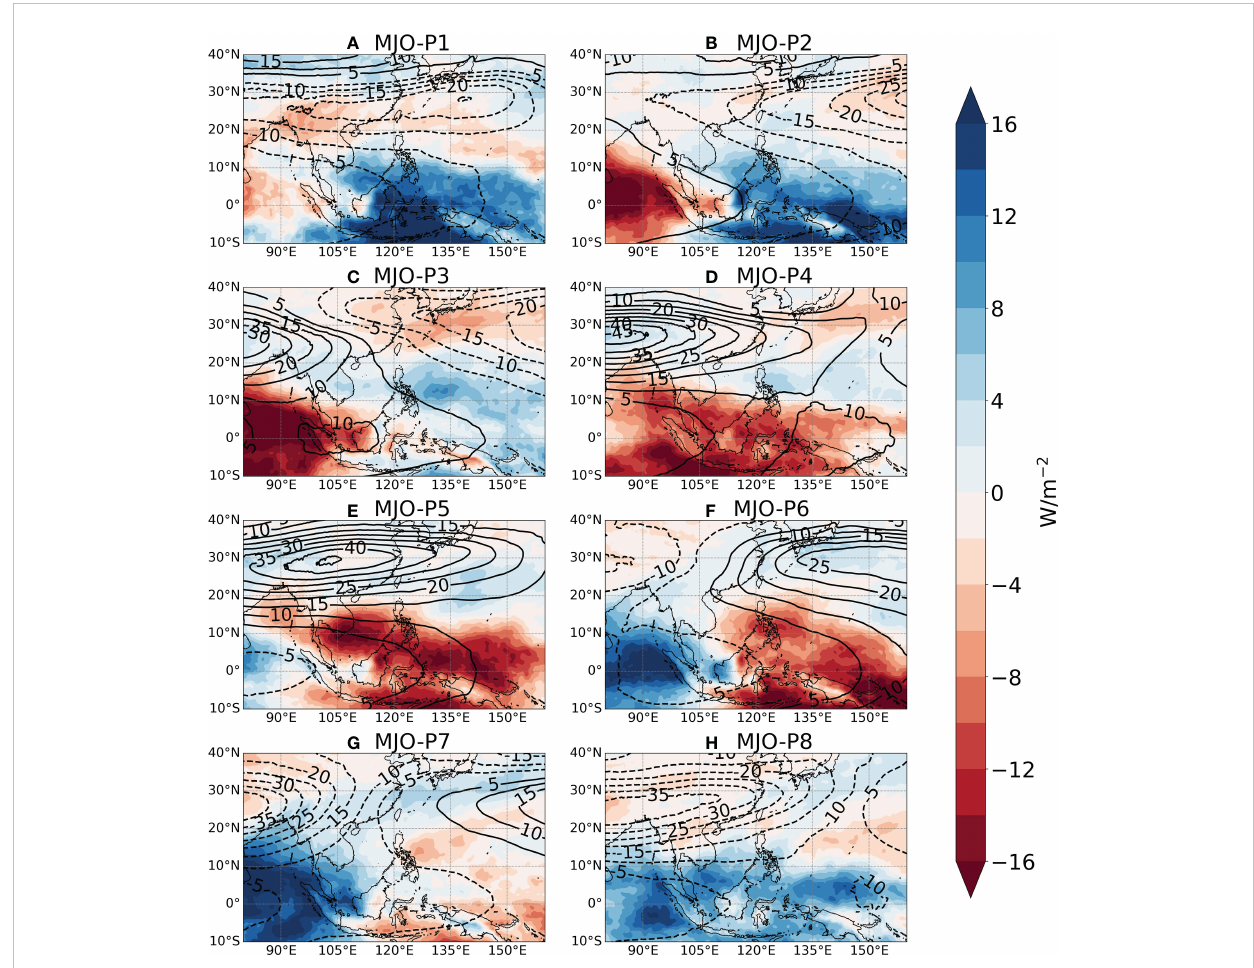
FIGURE 9 The anomalous geopotential thickness between 200 and 500-hPa (contour, unit: gpm) and anomalous Outgoing Longwave Radiation (color, unit: W/m 2 ) based on eight phases of MJO. (A – H) corresponding to phases 1 to